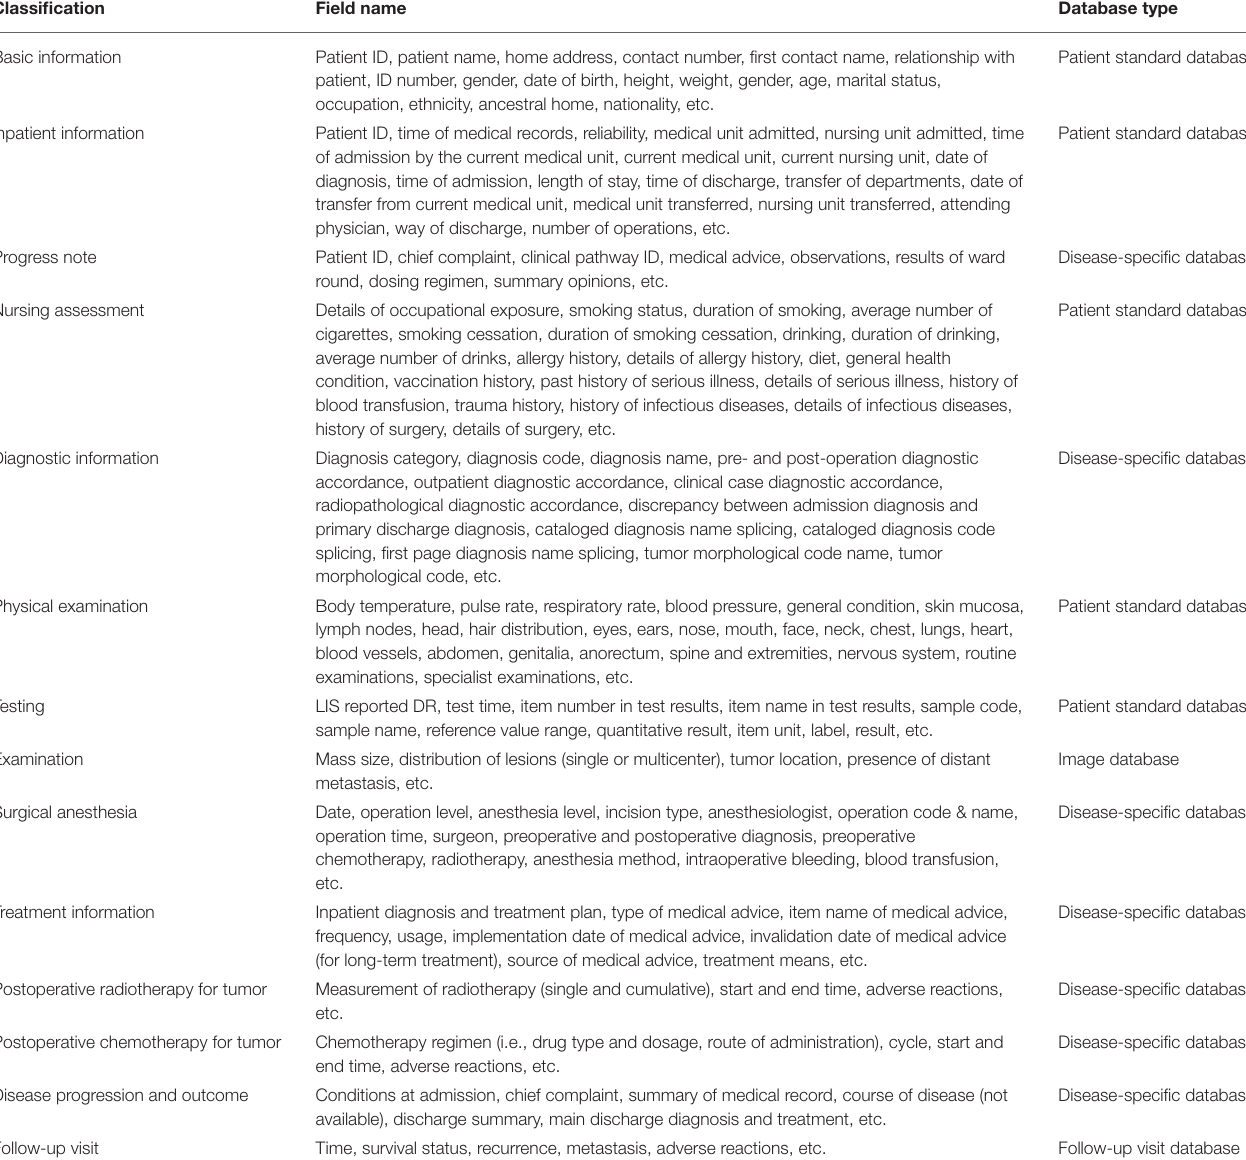
TABLE 3 | Some collected fields of the breast cancer-specific